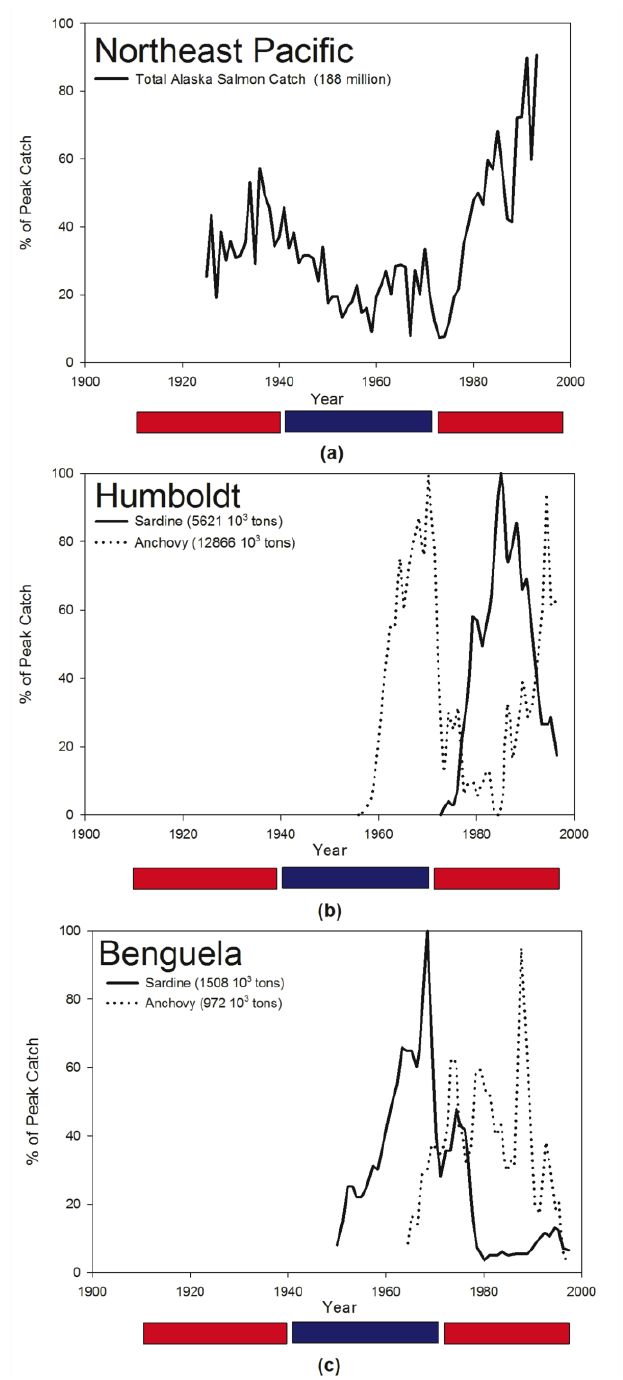
Figure 6. Fish landings of: ( a ) salmon in the Northeast Pacific; ( b ) sardines and anchovies in the Humboldt; and ( c ) anchovies and sardines in the Benguela current systems. Fish catch are given as the percent of peak catch of the time series, region specific. Values in figure legends represent the maximum landings of the fish catch over the time periods. The blue/red bars indicate the cool/warm phases over the last century. Data were adapted from Hare and Francis [92] (a), de Young et al. [93] (b,c). Species’ dominances are shown to change with the warm and cool phases. Species’ dominances are shown to change with the warm and cool phases which have been originally labeled NAO for Atlantic stocks and PDO/ Inderdecadal Pacific Oscillation (IPO) for Pacific